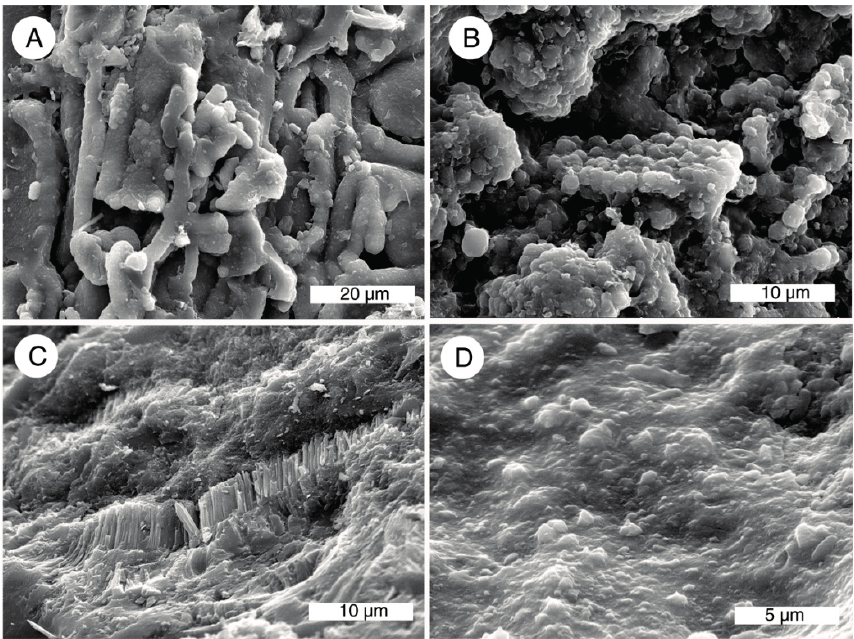
Figure 18. Evidence of diagenetic transformation of silica. ( A ) Tracheids coated with chalcedony, a texture common in opalized wood (e.g., Figure 6A); ( B ) Chalcedony showing structure reminiscent of opal lepispheres (e.g., Figures 5 and 6); ( C ) Chalcedony showing fibrous crystalline habit. (A – C) all from locality; ( D ) Chalcedony mineralized wood showing relict hemispherical texture typical of opal, locality